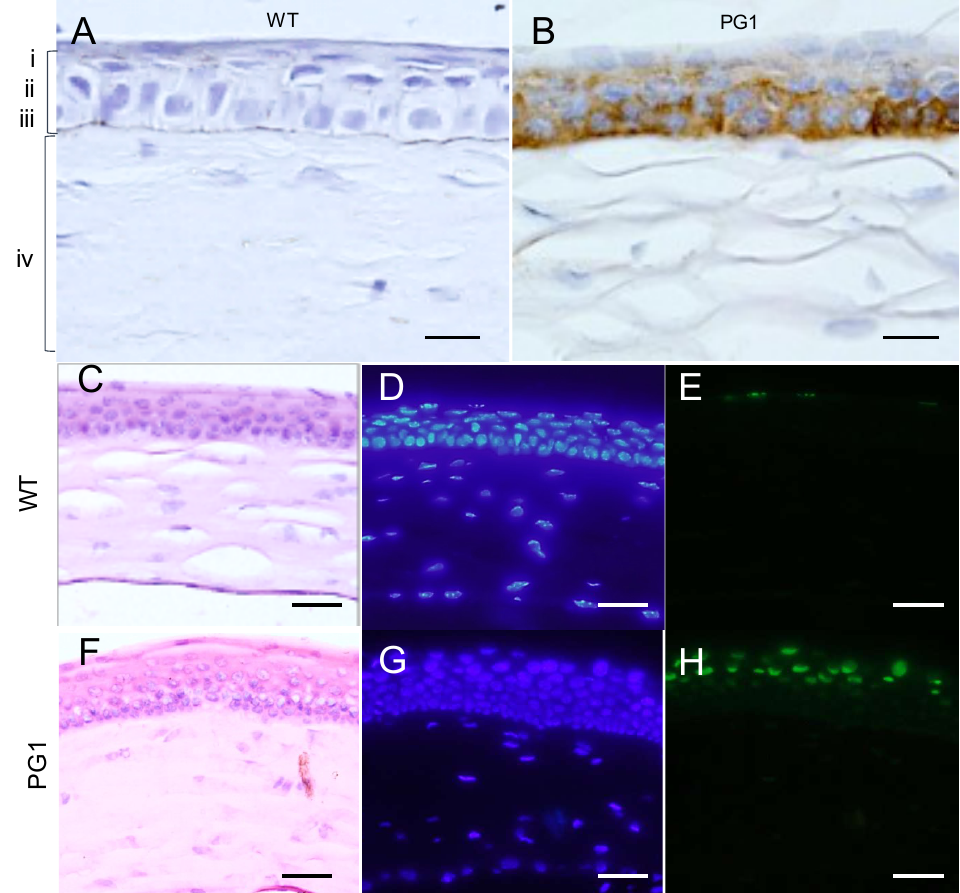
Figure 3. Results of immunohistochemical analyses using anti-PG1 antibodies and TUNEL assay against the cornea of PG1 transgenic mice affected with corneal opacity. ( A – H ) represent the results of anti-PG1 immunohistochemistry, H&E staining, DAPI staining, and TUNEL analysis, respectively. Corneal epithelium cells are marked as (i) squamous, (ii) wing, (iii) basal, (iv) stroma. ( A , C – E ) are from wild-type (C57BL/6) mice, while ( B , F , G , H ) are from PG1 transgenic mice. Basal cells of the cornea shown in brown were reactive with anti-PG1 antibodies by diaminobenzidine (DAB) staining ( B ). The anti-PG1 signals were similar between affected and not affected PG1 transgenic mice. TUNEL-positive signals were detected from the flat cells of the cornea of the transgenic mice ( H ). Opacity-affected eyes show thickened epithelia ( C ) vs. ( F ). Scale bars represent 20 µ m and 50 µ m. for ( A , B ) and ( C – H ), respectively.